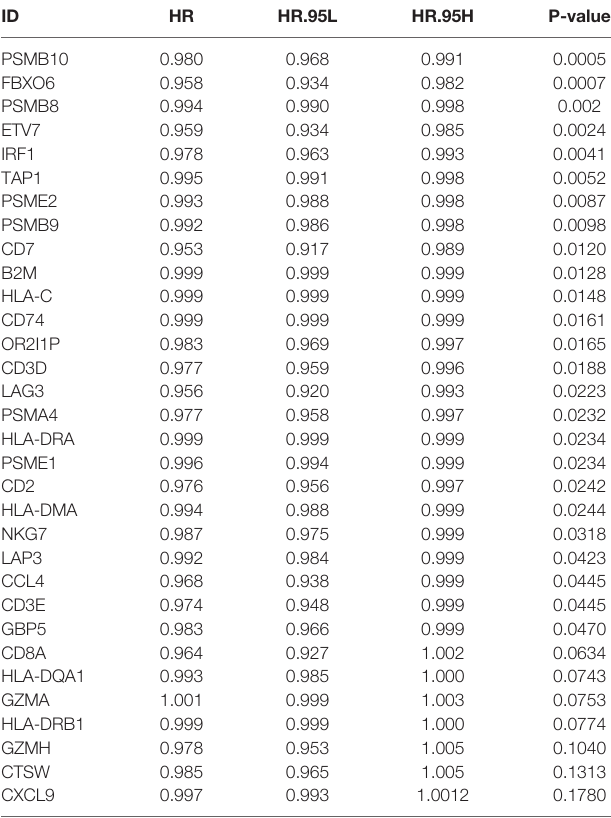
TABLE 2 | Univariate Cox proportional hazard analysis of CD8 + T cells related genes.